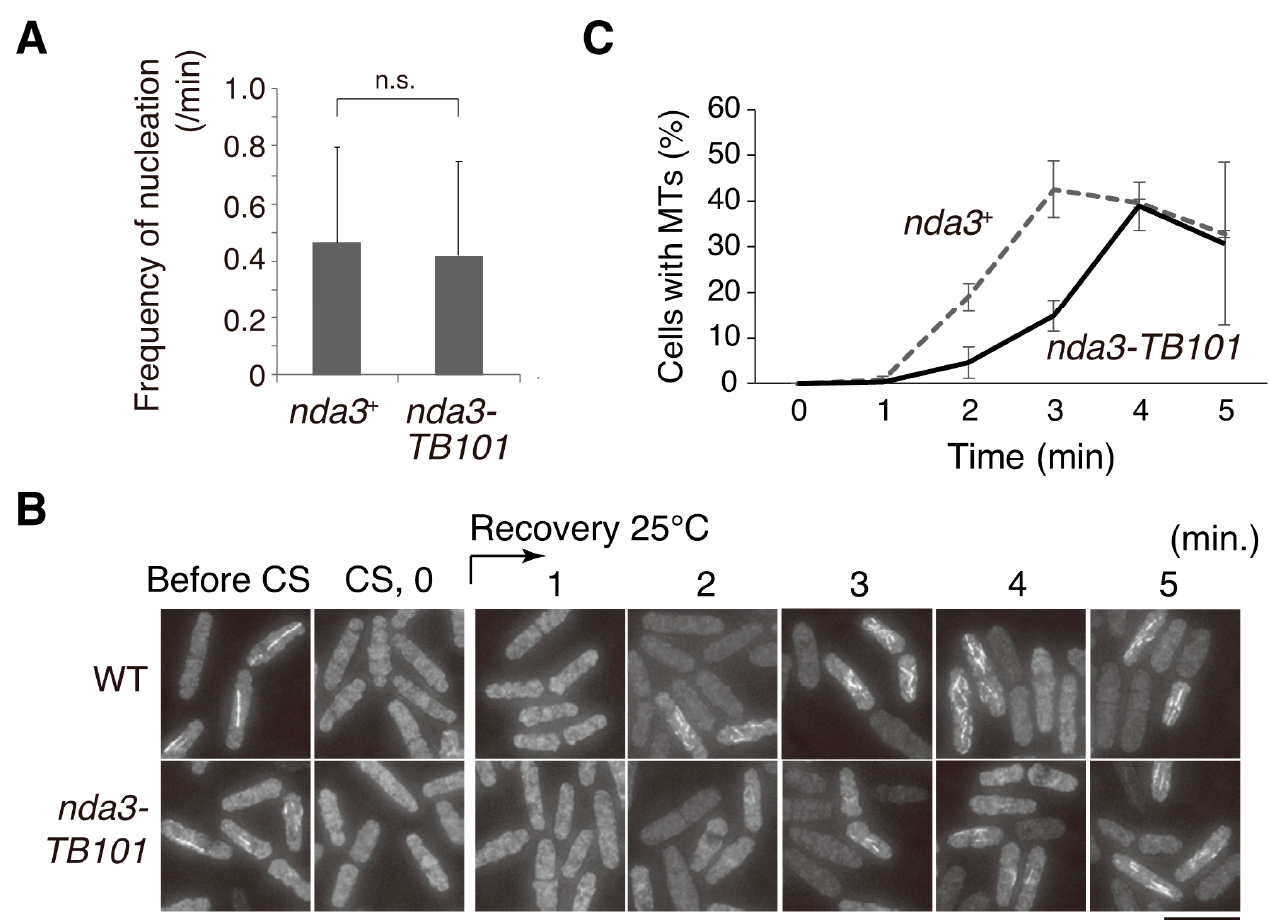
Figure 6. Microtubule nucleation is not promoted by the nda3-TB101 mutation. ( A ) Frequency of microtubule nucleation events was monitored during interphase of WT ( nda3 + ) and nda3-TB101 cells expressing GFP-Atb2. When a punctate signal of GFP-Atb2 appeared in the cytoplasm and then grew to a filament, the event was counted as microtubule nucleation in this study. The frequency of nucleation per minute per cell was counted. Cells, n = 20. Not significant, n.s. (Student’s t -test). ( B , C ) Microtubules were depolymerized by cold-shock treatment in WT and nda3-TB101 cells expressing GFP-Atb2, and regrowth was induced by temperature shift back. Microtubules were observed before (Before CS) and after (CS, 0 min) giving a cold shock ( B ). Microtubule regrowth was monitored every minute after the temperature shifted back. Scale bar, 10 µ m. Percentages of cells harboring punctate and/or filament signal of GFP-Atb2 at each time point ( C ). Cells, n > 300.